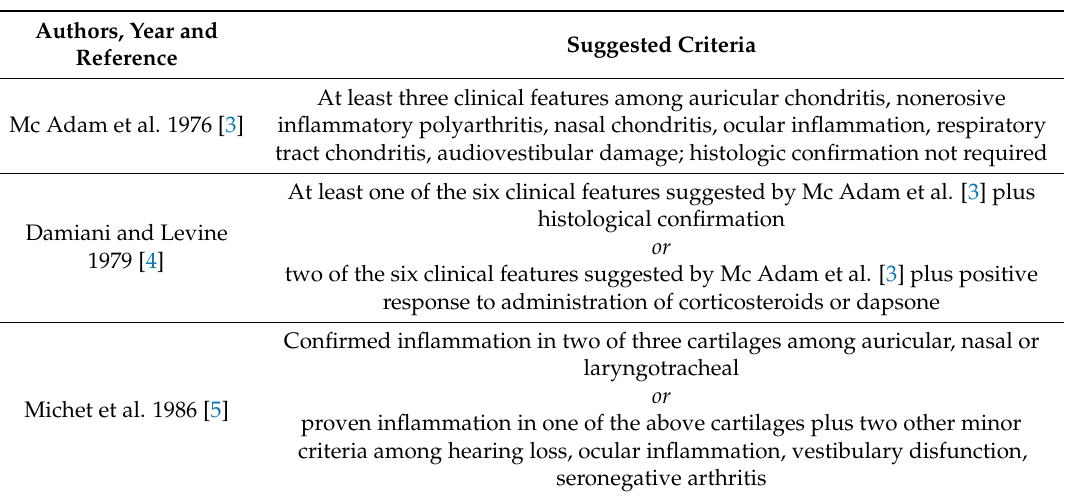
Table 1. Diagnostic criteria of relapsing polychondritis, according to different